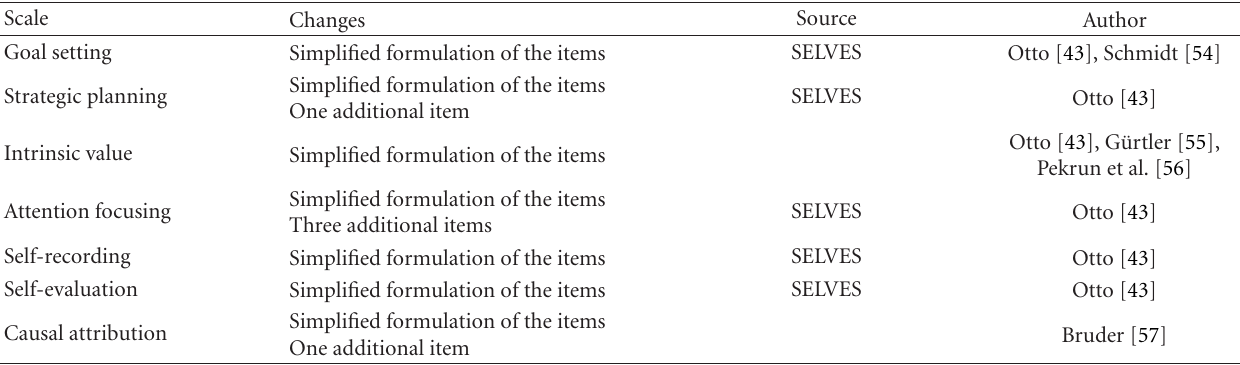
Table 2: Overview of the scales of the self-regulated learning questionnaire regarding the sources, authors, and changes.